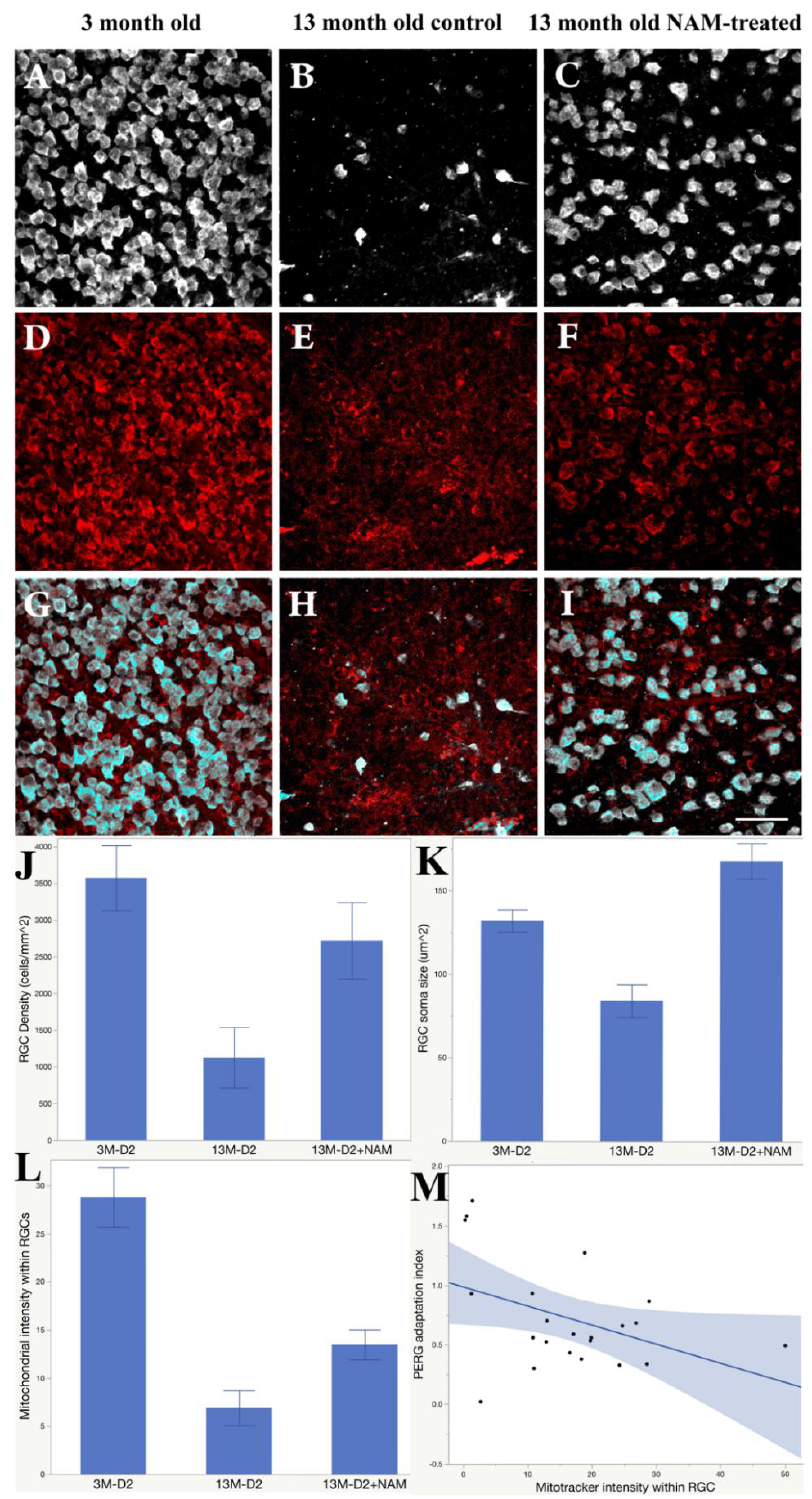
Figure 2. NAM supplementation rescues retinal ganglion cell (RGC) and mitochondria, and preserves flicker-induced PERG adaptation. Examples of RBPMS-labeled RGCs ( A ), mitotracker ( D ), and merged labeling ( G ) in 3-month-old D2 mice. ( B , E , H ) corresponding examples for 13-month-old control mice. ( C , F , I ) corresponding examples for 13-month-old NAM-tread mice (Scale bar: 50 µ m). ( J ) Mean (SE) RGC density (cells / mm 2 ); ( K ) mean (SE) RGC soma size ( µ m 2 ); ( L ) mean (SE) mitotracker intensity for the three groups of mice. ( M ) The Flicker-PERG adaptation index (test / baseline) decreases with increasing mitotracker intensity.